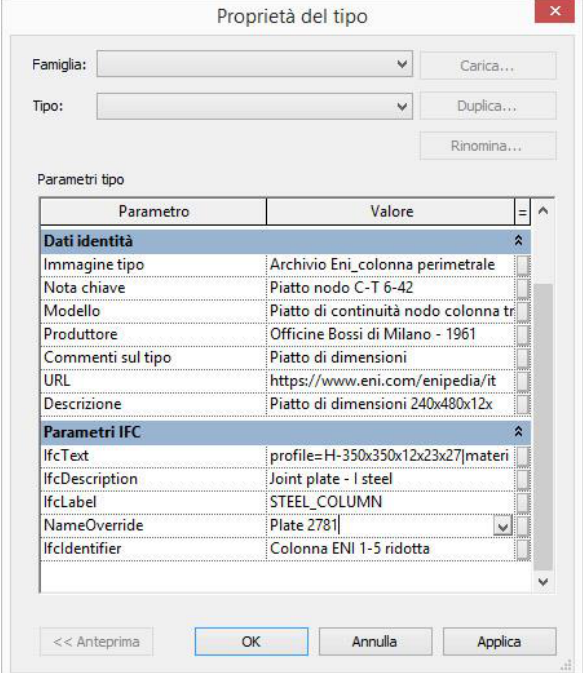
Figure 7: labels of the steel join shown in the figure 6, concerning several aspects, both structural and